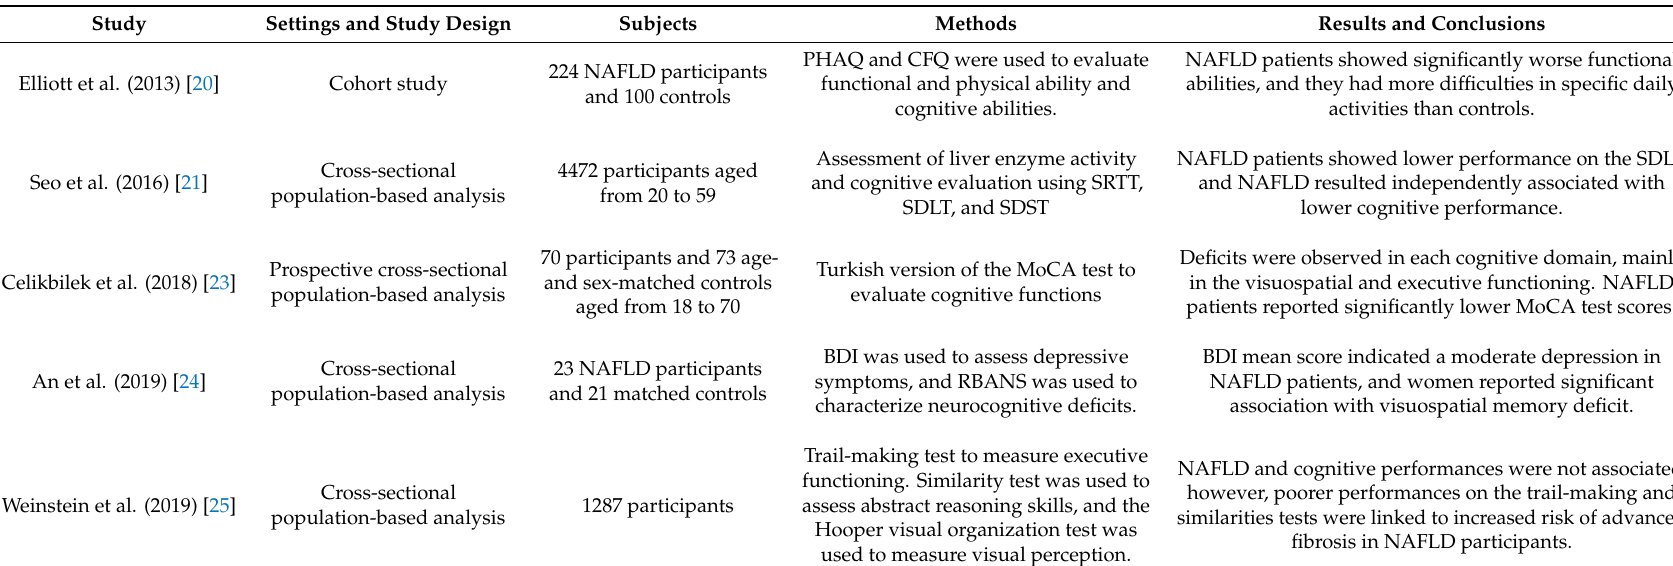
Table 2. Principal clinical studies reported on cognitive impairment, MCI, and NAFLD